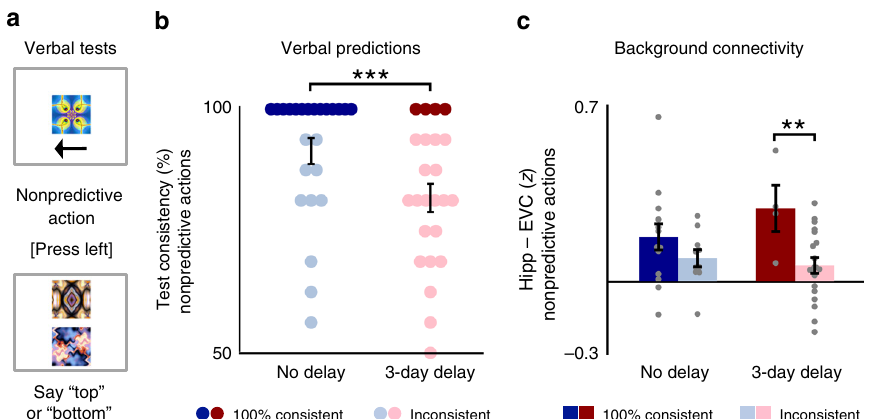
Fig. 5 Verbal predictions for nonpredictive actions. a Verbal tests administered immediately before and after each fMRI scan included sequences with nonpredictive actions as well as sequences with predictive actions. b Participants more consistently identi fi ed particular outcomes for nonpredictive cues and actions learned immediately beforehand than before the 3-day delay. However, a subset of participants for each timescale were 100% consistent in identifying outcomes of nonpredictive actions. c Participants who consistently mapped nonpredictive cues and actions to particular outcomes showed greater background connectivity for these nonpredictive events after the 3-day delay. Error bars indicate ± 1 SEM. *** p < 0.001 (paired t -test); ** p < 0.01 (two-sample t -test). Source data are provided as a Source Data fi